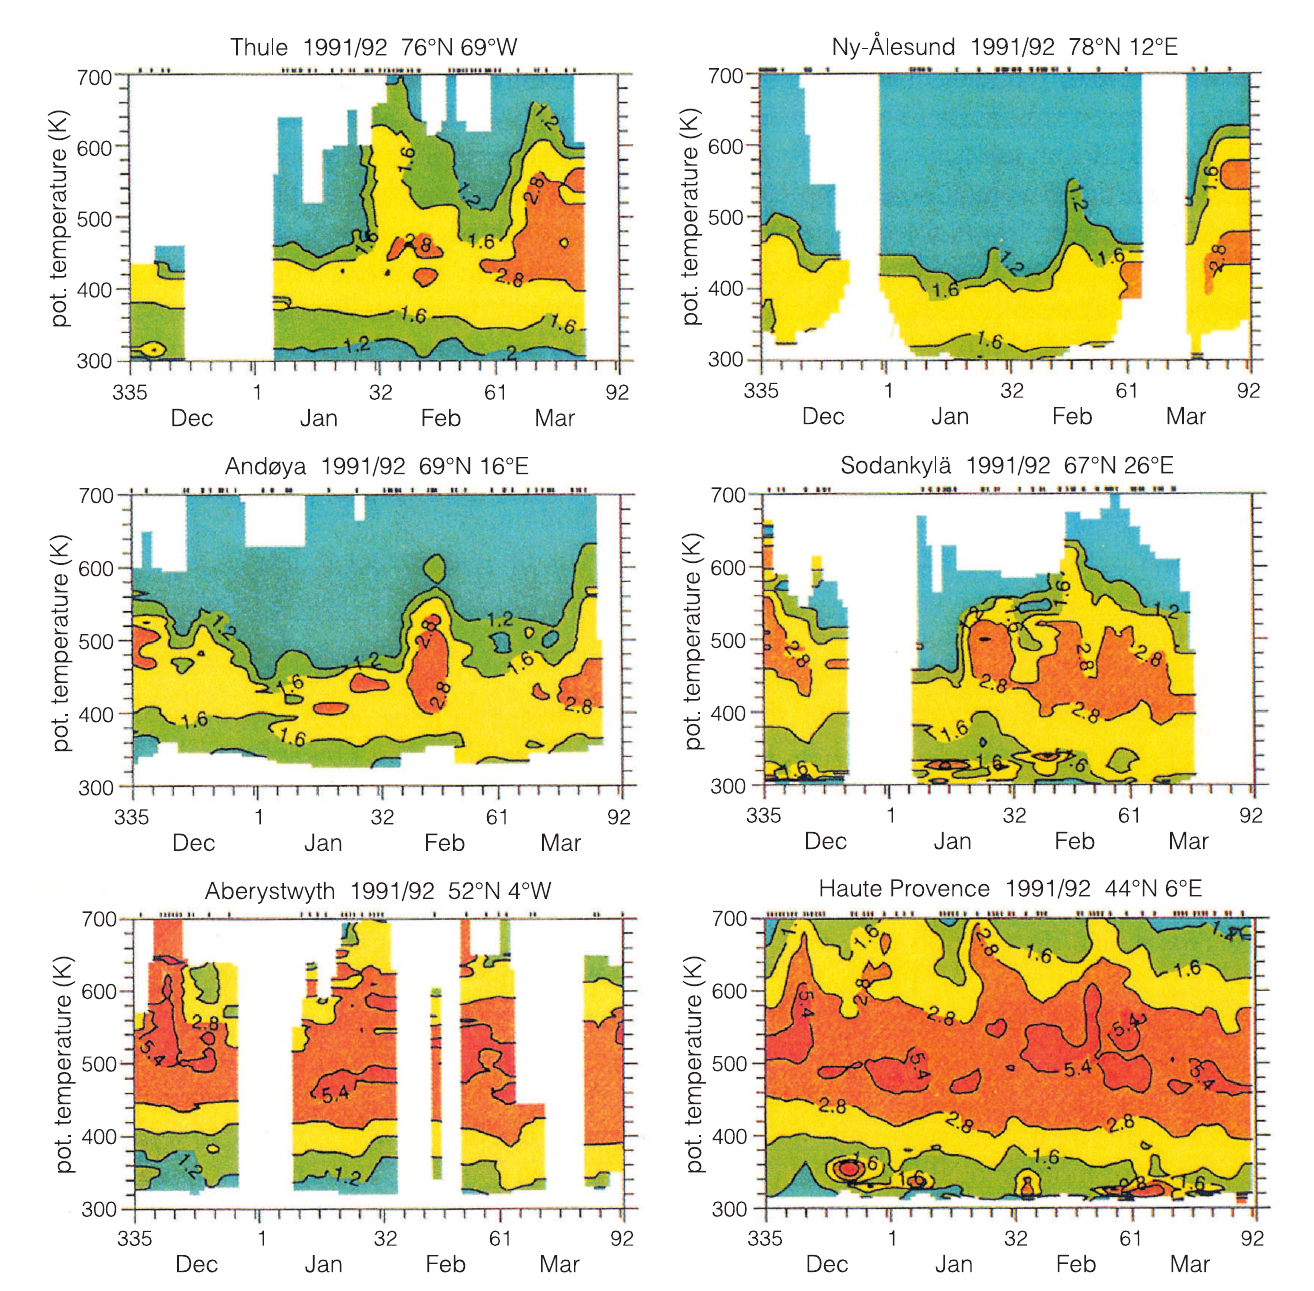
Fig. 7. Temporal development of the backscatter ratios at six lidar stations in the period December 1991 through March 1992 during EASOE (European Arctic Stratospheric Ozone Experiment). The bars above the plots indicate times of the measurements. Isolines are set to values of 1.2, 1.6, 2.8, and 5.4 in order to reveal greater details for the lower values. Adapted from Neuber et al. (1994) (copyright by the American Geophysical Union).